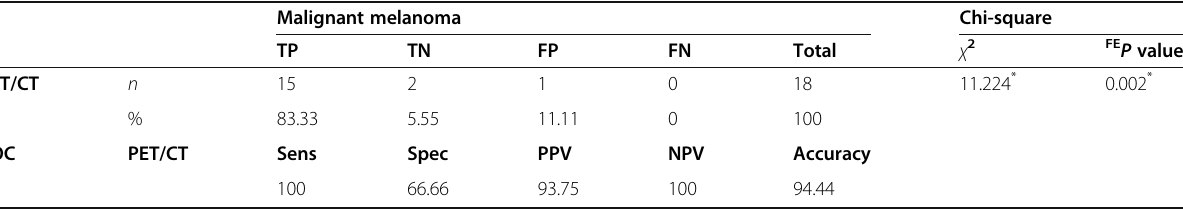
Table 7 Sensitivity, specificity, accuracy, PPV, and NPV of PET/CT in detection of distant metastasis of G3, n = 18 melanoma